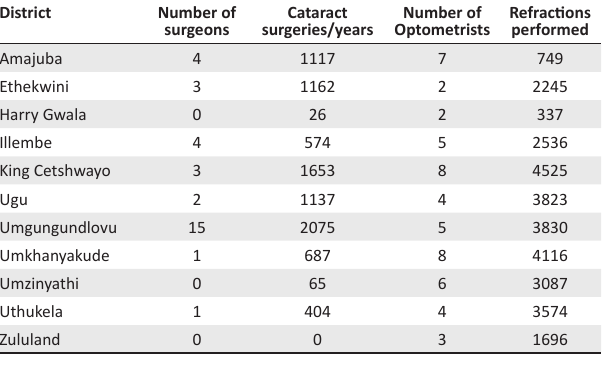
y = 314.38x + 1231 R ² =